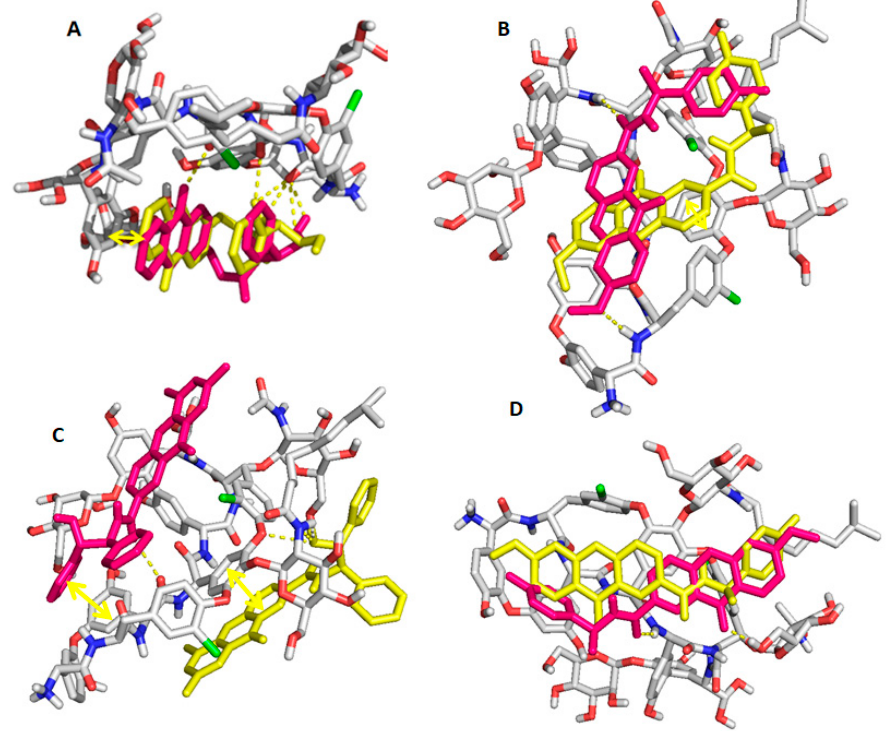
Figure 8. Analyte 1 ( A ), Analyte 14 ( B ), Analyte 30 ( C ), and Analyte 18 ( D ), docked on teicoplanin selector. Chiral selectors are represented in sticks with C, O, N, and Cl atoms colored in grey, red, blue, and green, respectively. ( S ) and ( R ) enantiomers are represented with magenta and yellow sticks, respectively. Hydrogen interactions and π -stacking interactions are represented with dashes and double arrow, respectively.